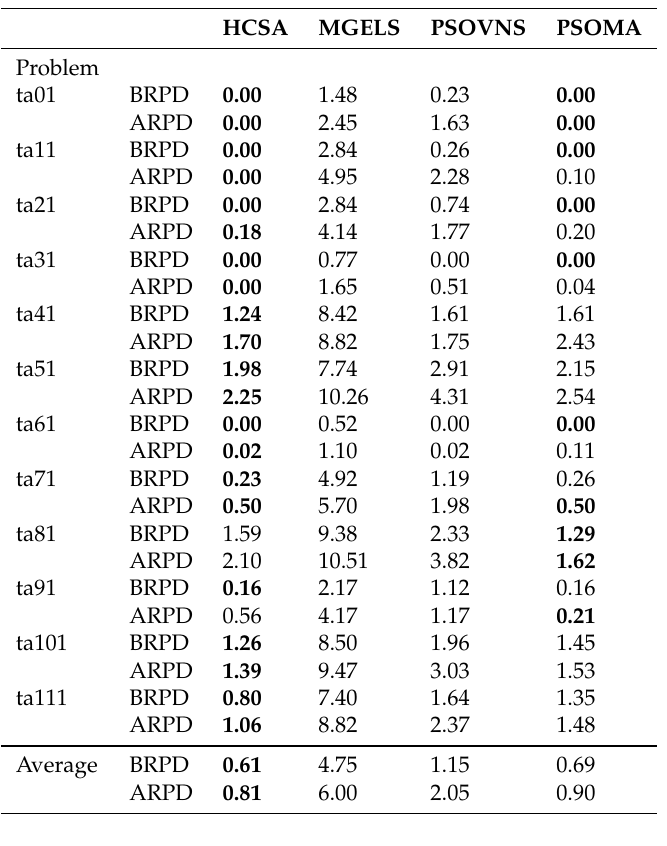
Table 8. Comparison tests of various meta-heuristic algorithms.